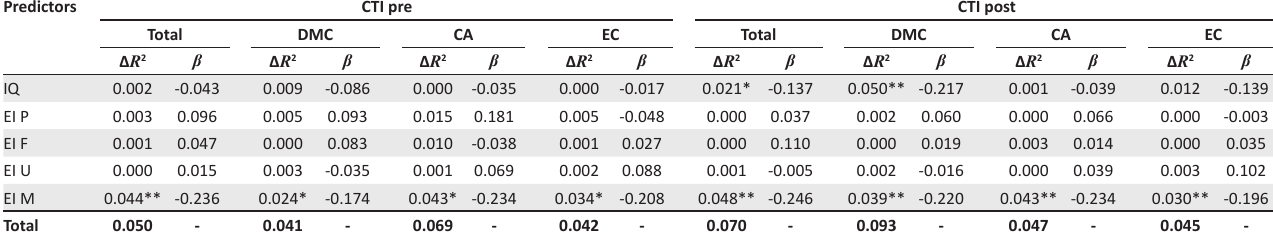
TABLE 3: Summary of multiple regression analysis for variables predicting negative career thoughts pre-programme and post-programme. Predictors CTI